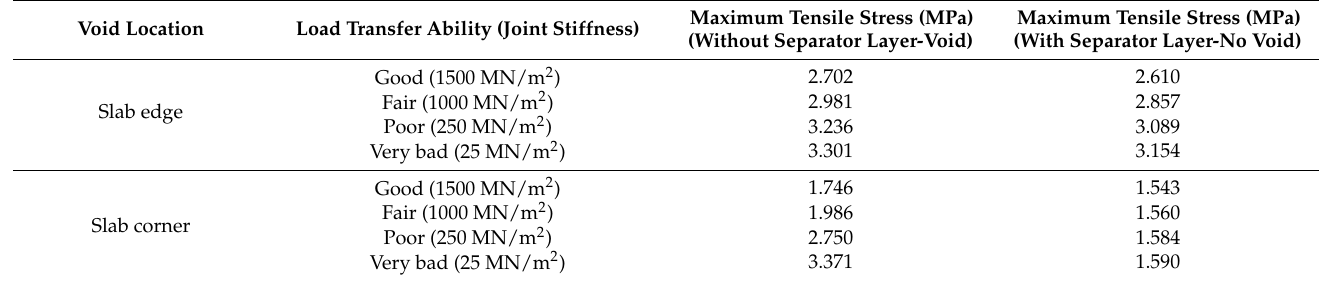
Table 7. Maximum tensile stress in concrete with/without separator